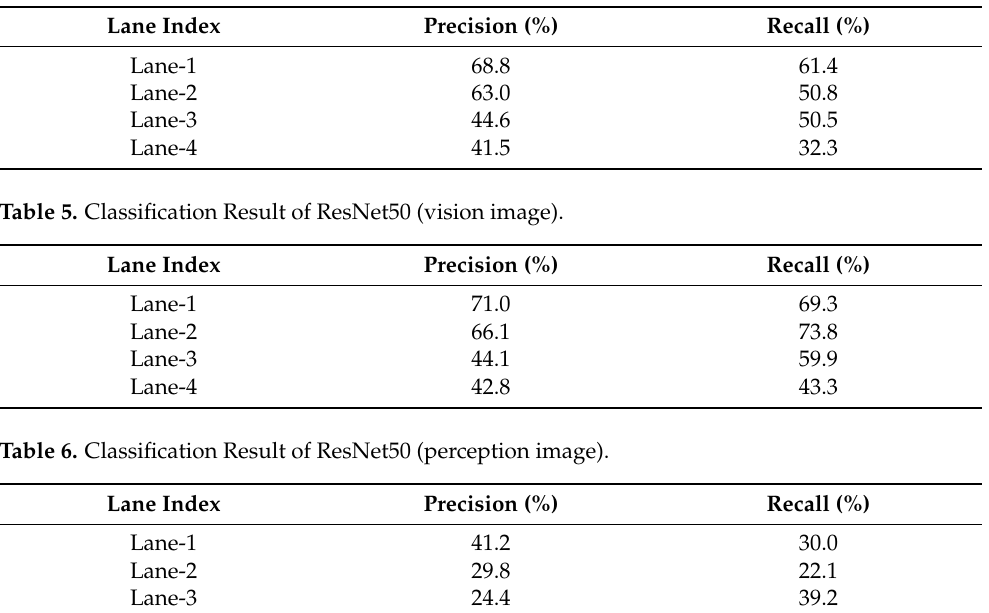
Table 4. Classification Result of ResNet18 (perception image).